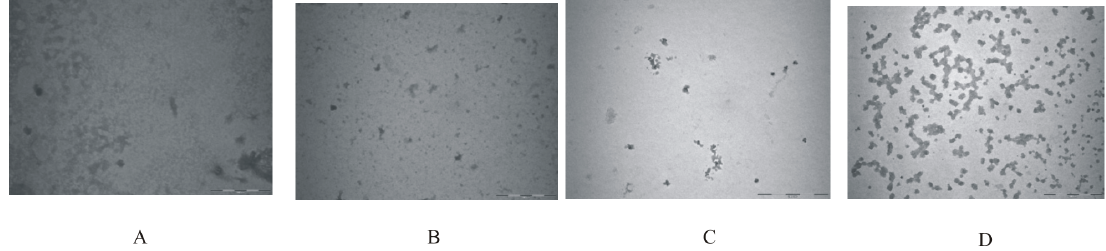
Figure 5. TEM images of lysozyme under different incubation conditions: images (A), (B), (C) and (D) are those for lysoyme solution incubated at 57 6 C in presence of L-proline, 4-hydroxy L-proline, sarcosine and TMAO respectively.